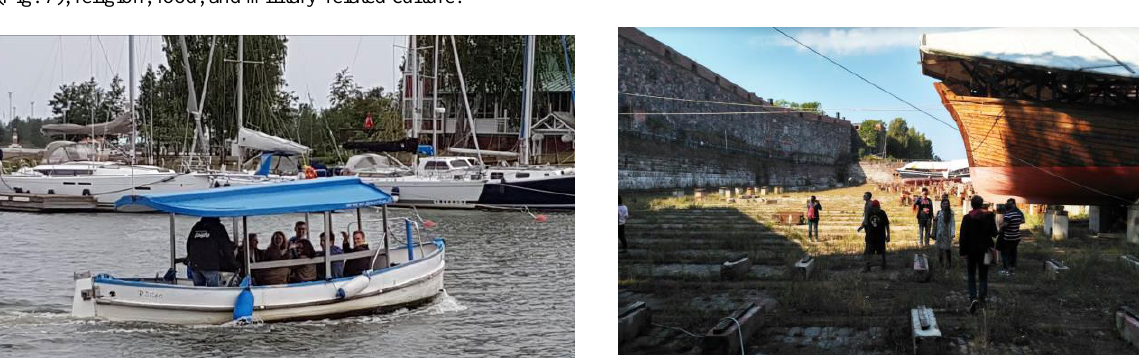
Figure 5. Visit to protected natural heritage site, Eastern Gulf of Finland National Park